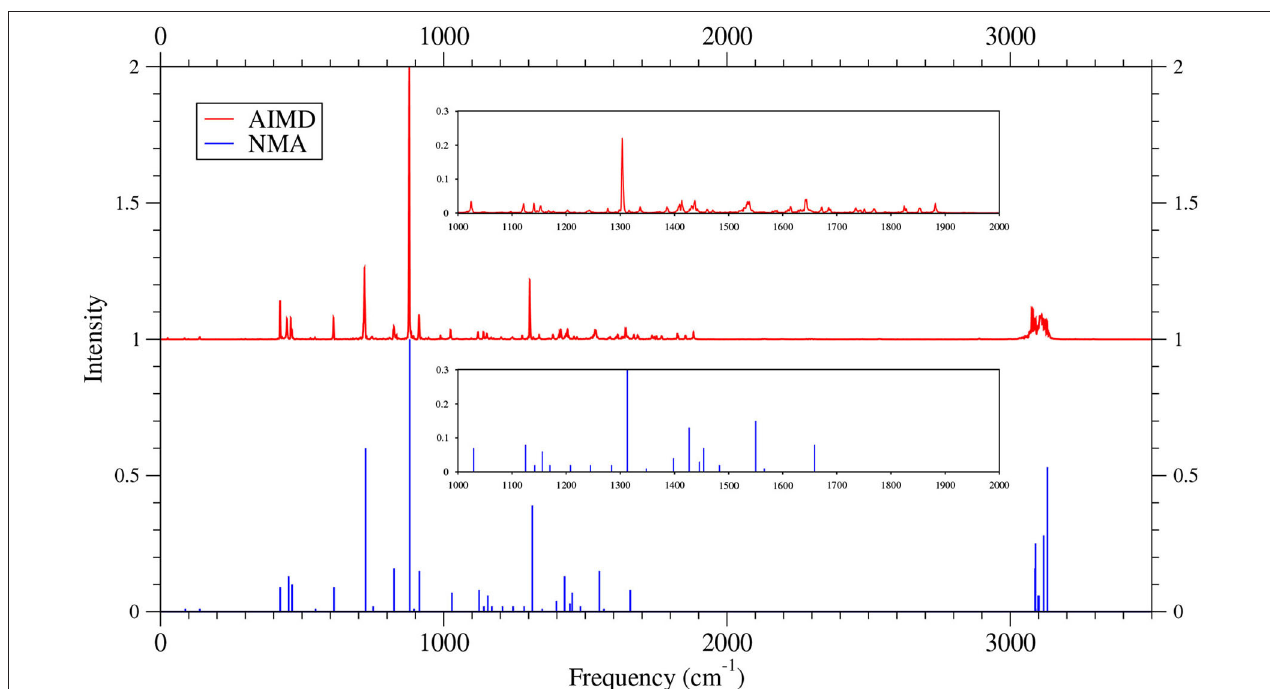
FIGURE 10 | IR spectra of 6-acene, obtained with the TAO-AIMD simulations at 300 K and GS-NMA, calculated by TAO-LDA. The IR spectra are normalized to have a maximum intensity of one and, for clarity, are vertically offset from each other by the same value. Subfigures show the IR spectra in the 1,000–2,000 cm − 1 range.